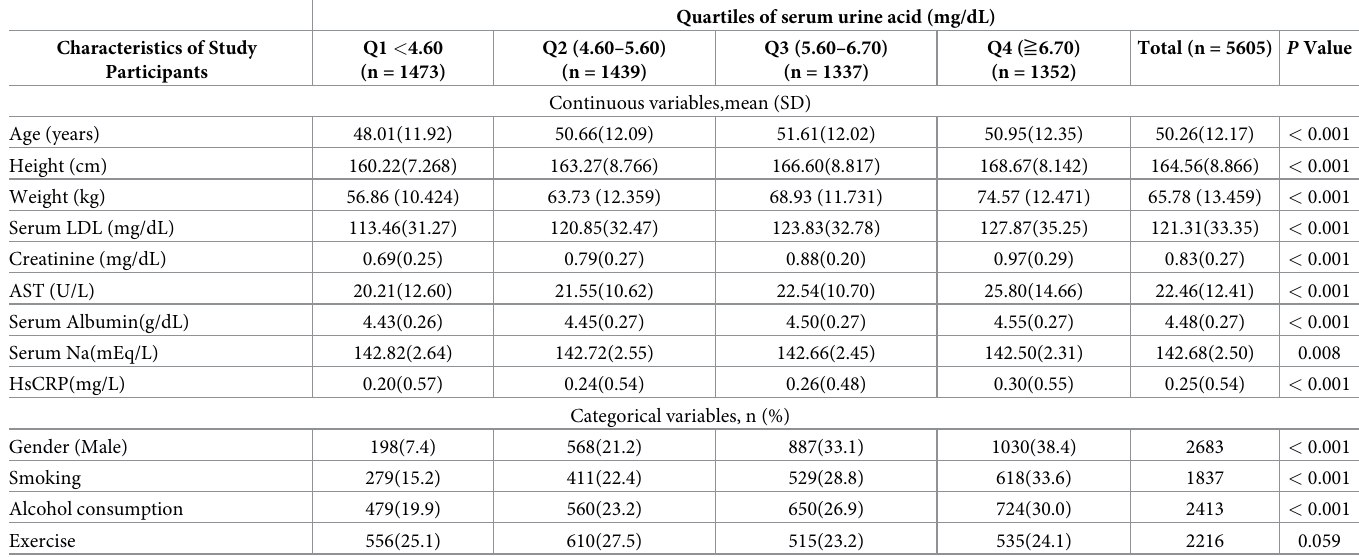
Table 2. Characteristics of study participants.